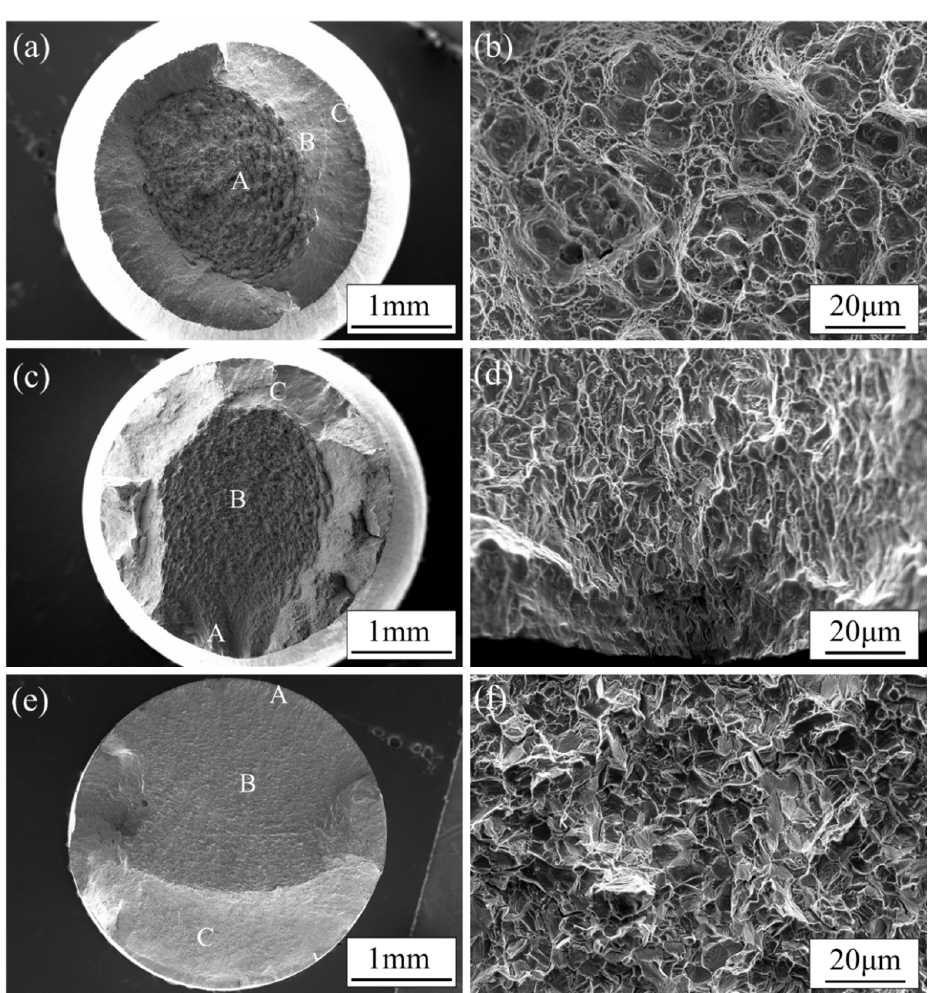
Figure 7. The SEM fractography images of tensile specimens: ( a,b ) NPO specimen, ( c , d ) PO20 specimen, and ( e , f ) PO60 specimen.